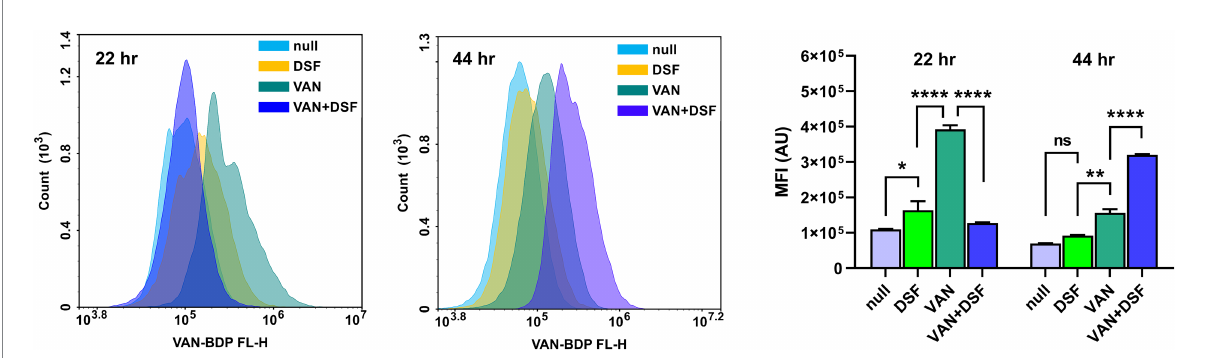
FIGURE 3 Comparison of flow cytometry histograms and mean fluorescence of Mu50 labeled with VAN-BDP FL following 22 and 44 h treatment with 1 × MIC DSF and/or 0.5 × MIC VAN. Data represents the mean fluorescence intensity (MFI) and statistical significance depicted with asterisks (ns = p > 0.05; * p ≤ 0.05; ** p ≤ 0.01; **** p ≤ 0.0001).